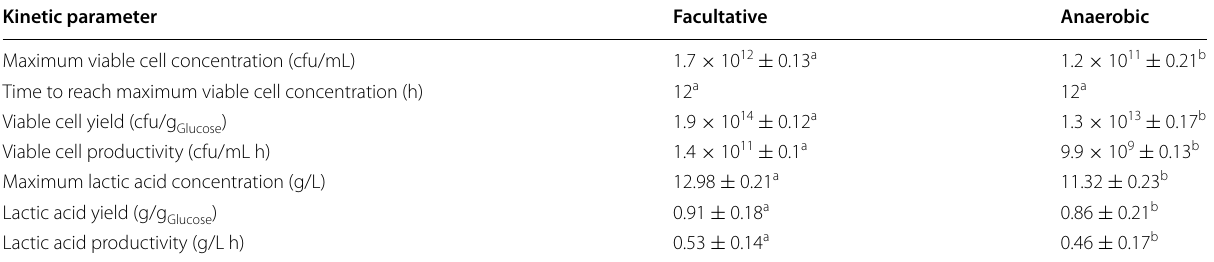
standard deviation ±